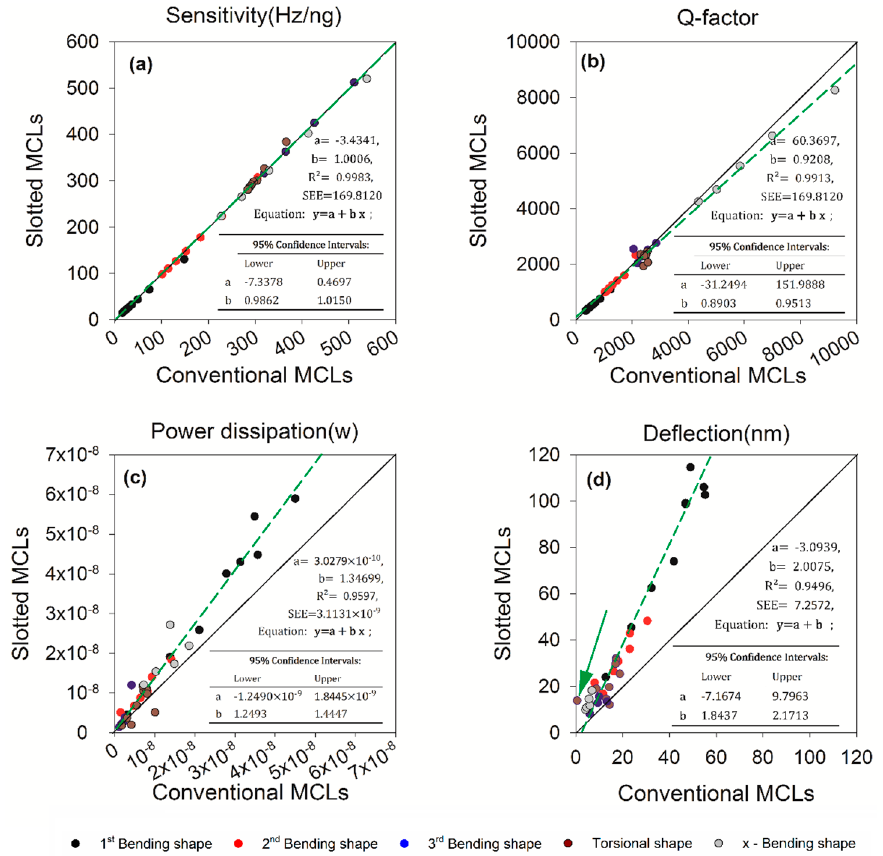
Figure 10. Variation in slotted and conventional MCLs. ( a ) The sensitivity change of structure between slotted and conventional MCLs, ( b ) The Q-factor change between slotted and conventional MCLs, ( c ) The power dissipation between slotted and conventional MCLs, ( d ) The maximum deflection at the piezoresistive resistance area (along MCL length, 50 µ m), the green arrow refers to the point ( σ lw = 1, torsional mode) where the deflection increases is the largest one.